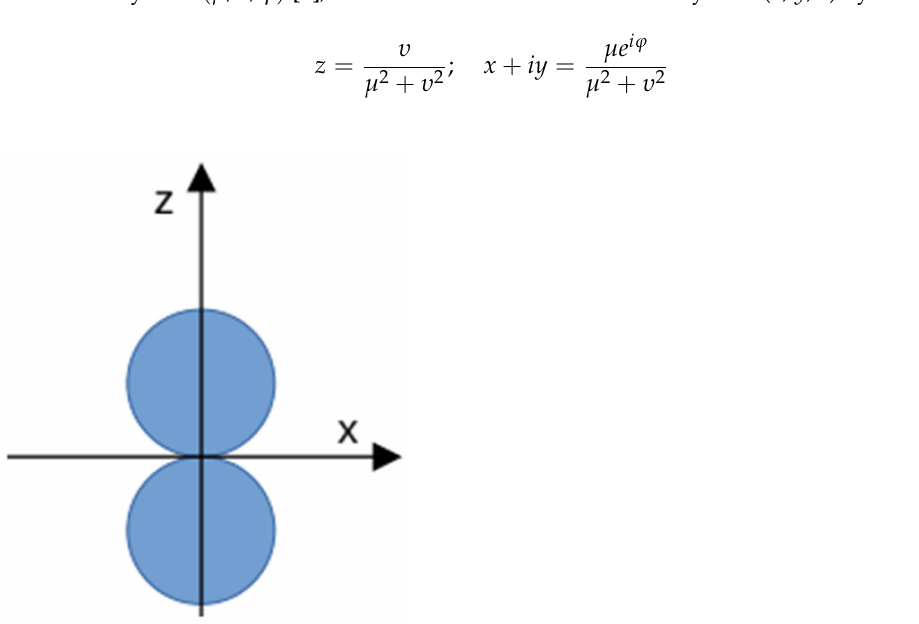
Figure 1. Schematic description of the problem of a dimer that is composed of two geometrically identical spheres in free space as in Sections 2–5 and Section 7. The dimer is subjected to: a uniform AC electric field acting in the z direction (Sections 2–5 and Section 7), a uniform AC electric field acting in the x direction (Section 3), and a non-homogeneous axisymmetric travelling wave propagating along the z direction (Section 4). The two spheres are identically conductive in Sections 2–5, and in Section 7 the lower sphere is coated by a thin dielectric